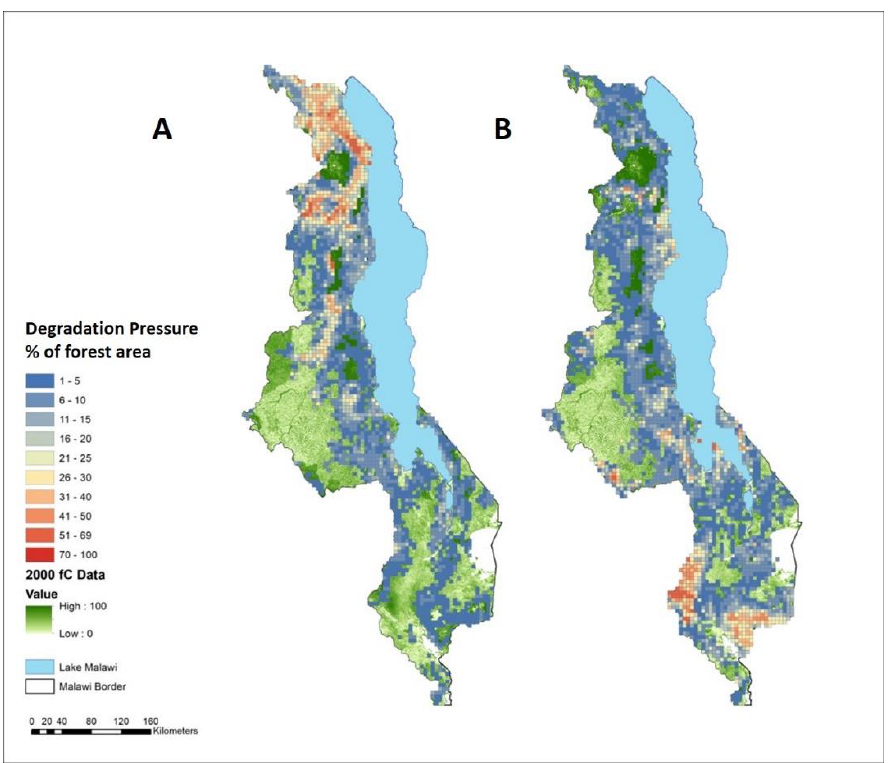
forest area in each 25 km 2 grid cell.